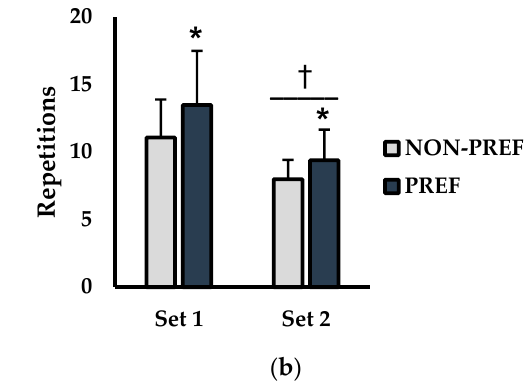
Figure 1. Barbell velocity and repetitions to failure analysis between non-preferred (NON-PREF) and preferred (PREF) warm-up music conditions ( a ) Average mean velocity (m·s − 1 ) of the first 3 repetitions of each set ( b ) Repetitions completed for each set. Data are presented as mean ± SD. * indicates significantly different from NON-PREF ( p ≤ 0.05). † indicates significantly different than set 1 ( p ≤